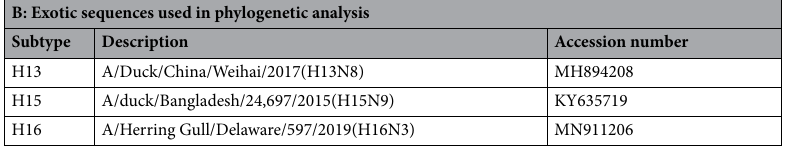
Table 1. Viral strains and sequences used in the study divided into custom Australian specific database for HA segment identification and exotic sequences used in the phylogenetic analysis. All viruses are denoted with common nomenclature detailing influenza virus, sample host, location and